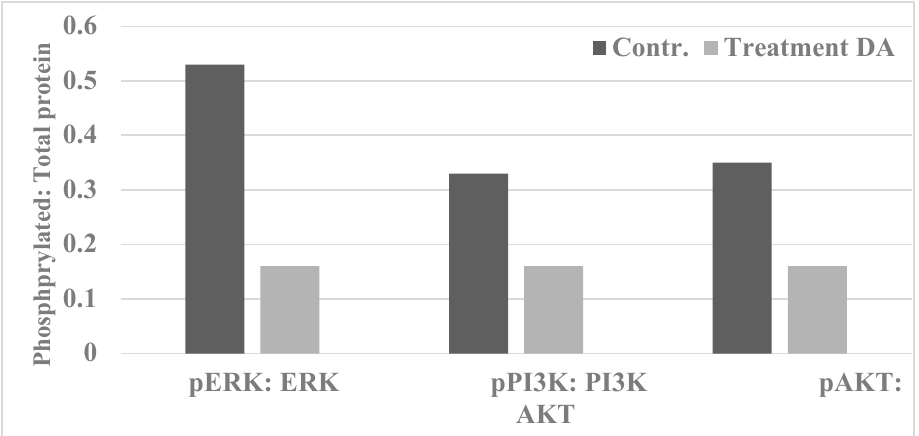
Figure 4. Effect of Chinese herbs on RAS, PI3K, and AKT signaling. Treatment with DA at its IC 90 dose inhibited the phosphorylated: total protein ratio. Data presented as arithmetic means of phosphorylated: total protein ratio of ASU from duplicate determinations. ERK, extracellular receptor kinase; PI3K, phosphatidylinositol 3-kinase, AKT, Protein kinase B; ASU, arbitrary scanning unit. Contr, control; Treatment: DA, Dipsacus asperoides . Data summarized from [16].